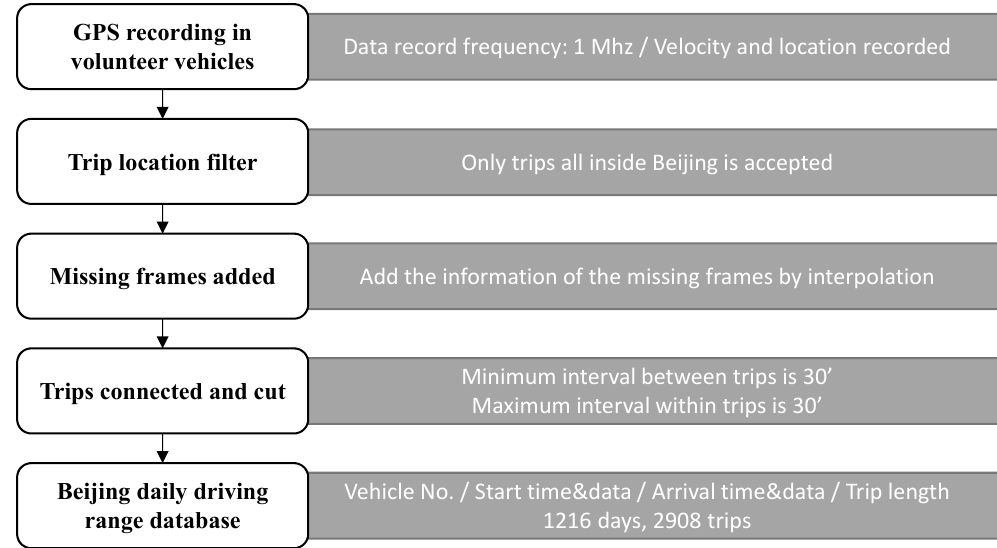
Figure 4. The daily driving range database